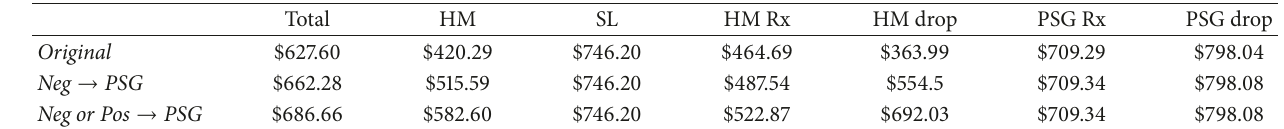
Table 4: Costs with adjusted patient flow.